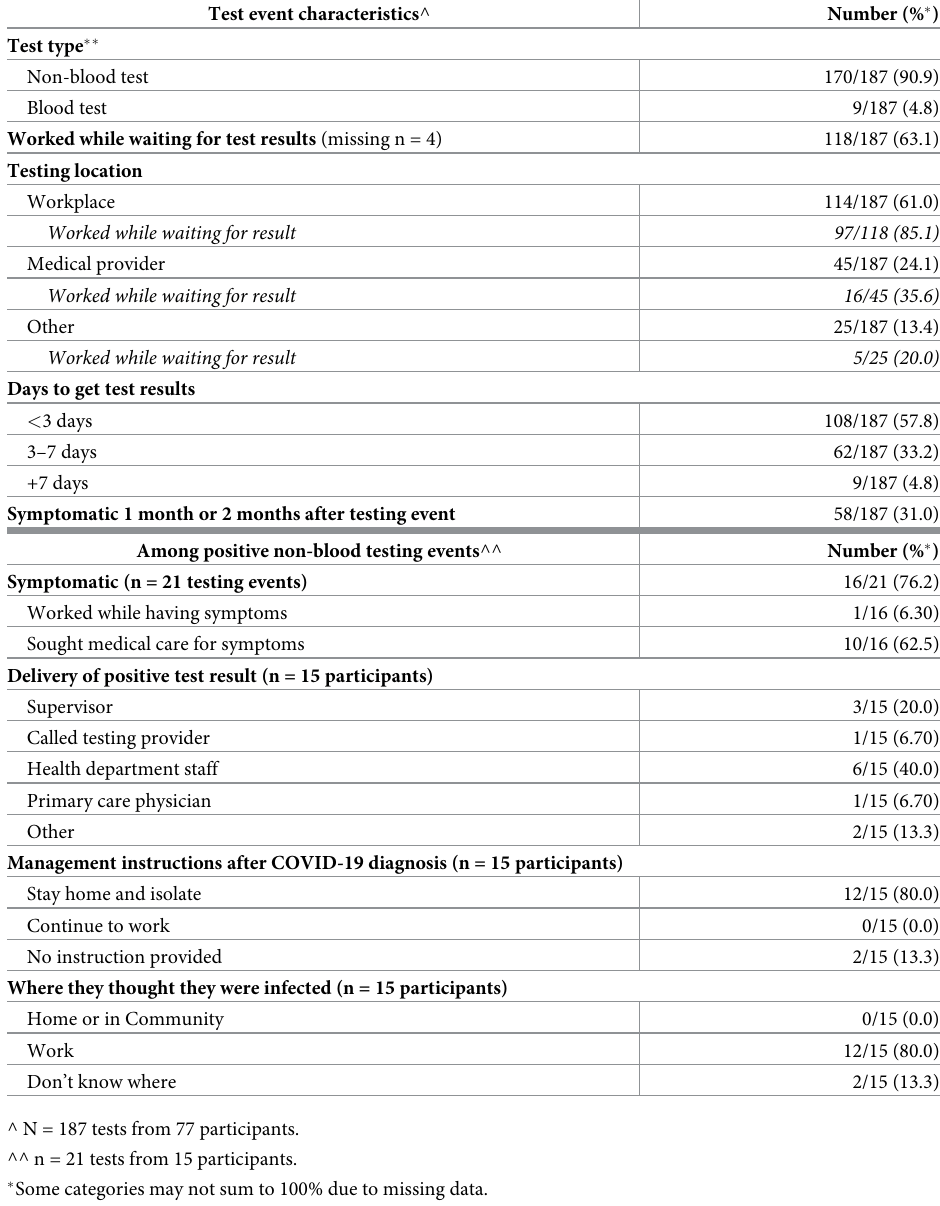
Table 3. Homeless shelter workers’ self-reported COVID-19 testing type, test locations, and symptoms and miti- gation measures around the time of testing